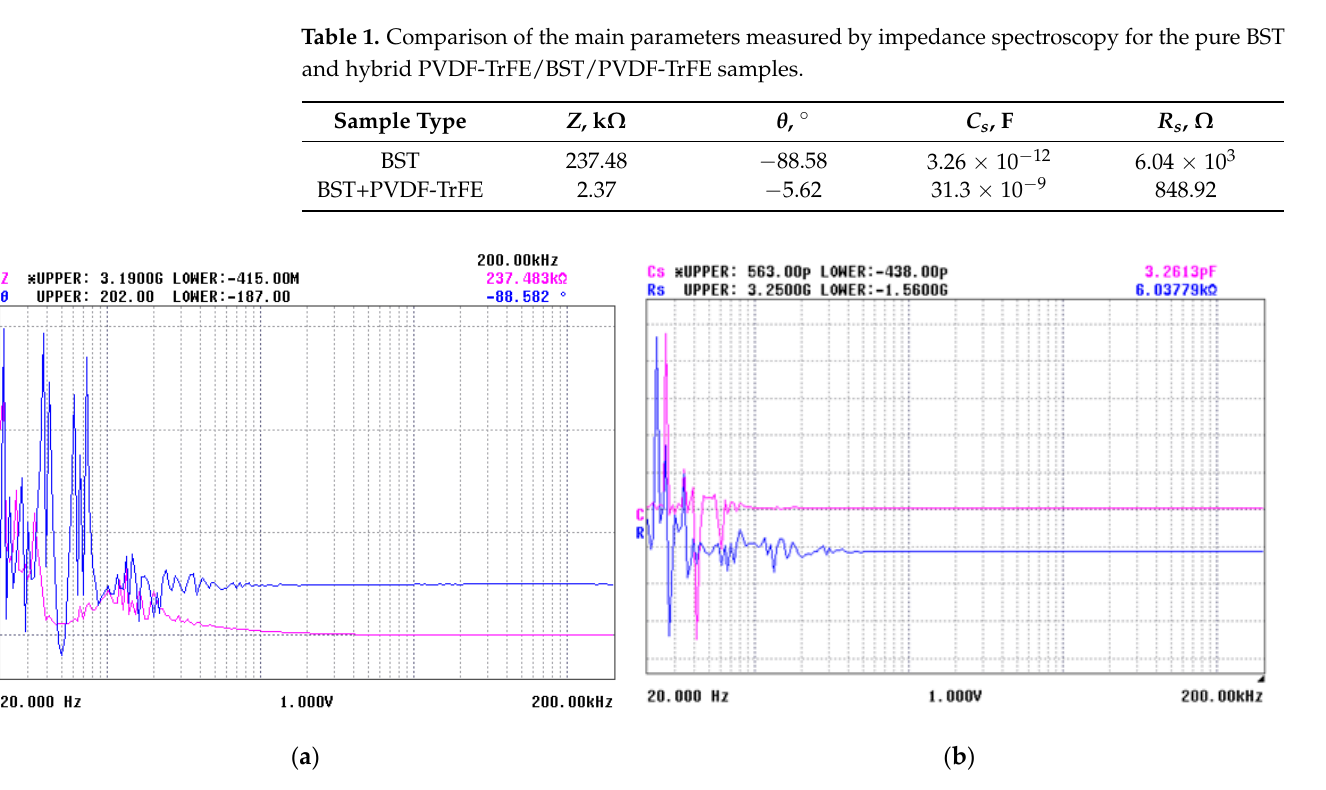
Figure 2. Bode plot ( a ) and frequency sweep of the contact parameters ( b ) of BST sample.